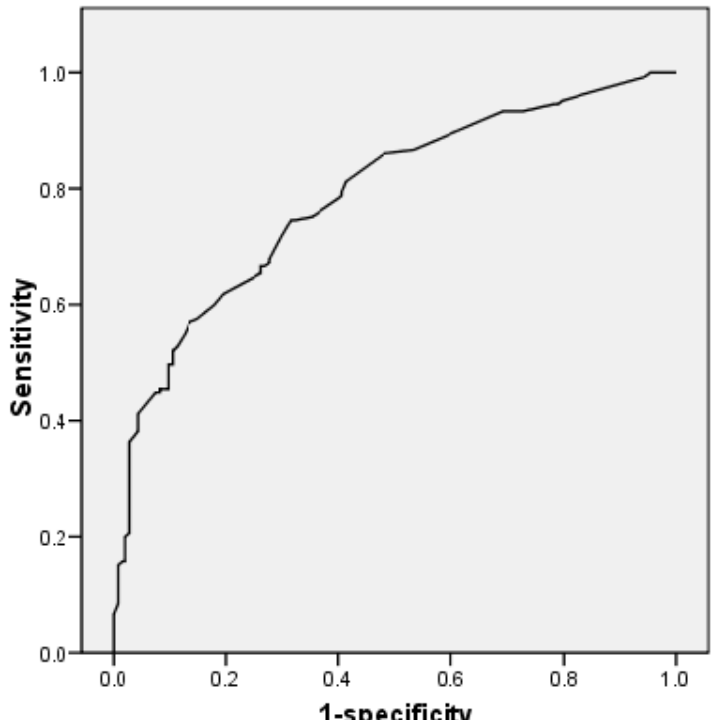
Figure 4. ROC curve for regression model including demographics, cerebrovascular risk factors, clinical features, and outcomes. Area under the curve = 0.785. ROC: receiving operating character- istics.